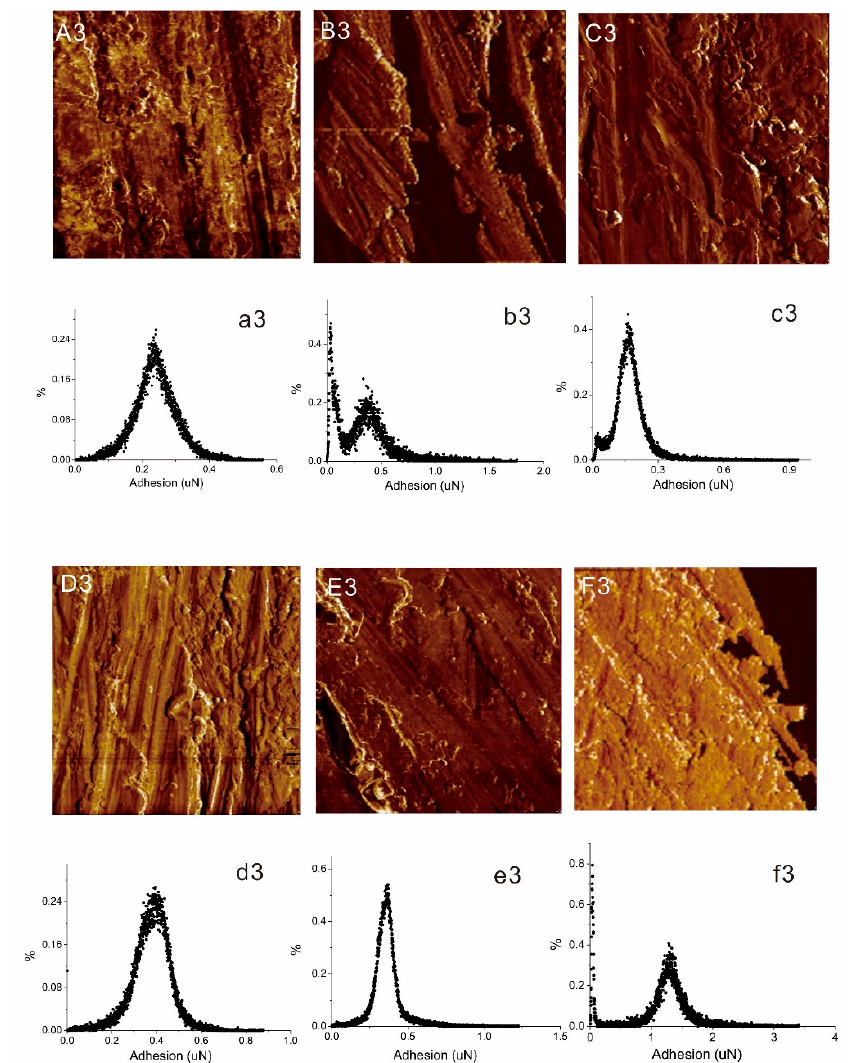
Figure 9. AFM adhesion force maps of a 30 × 30 μ m 2 region, and adhesion force distribution graphs of ( A3, a3 ) FFRP; ( B3, b3 ) MP-FFML; ( C3, c3 ) MPAL-FFML; ( D3, d3 ) MPALSi-FFML; ( E3, e3 ) P2-FFML; ( F3, f3 ) P2Si-FFML.